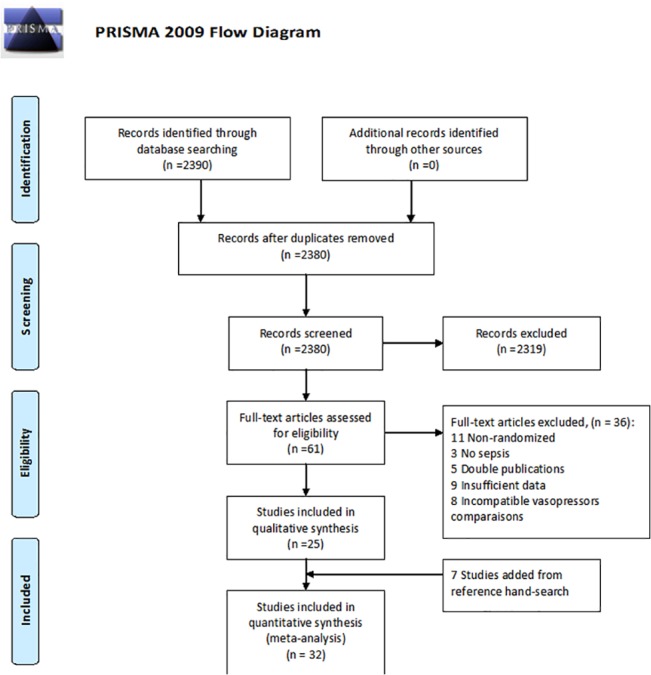
Study flow chart.